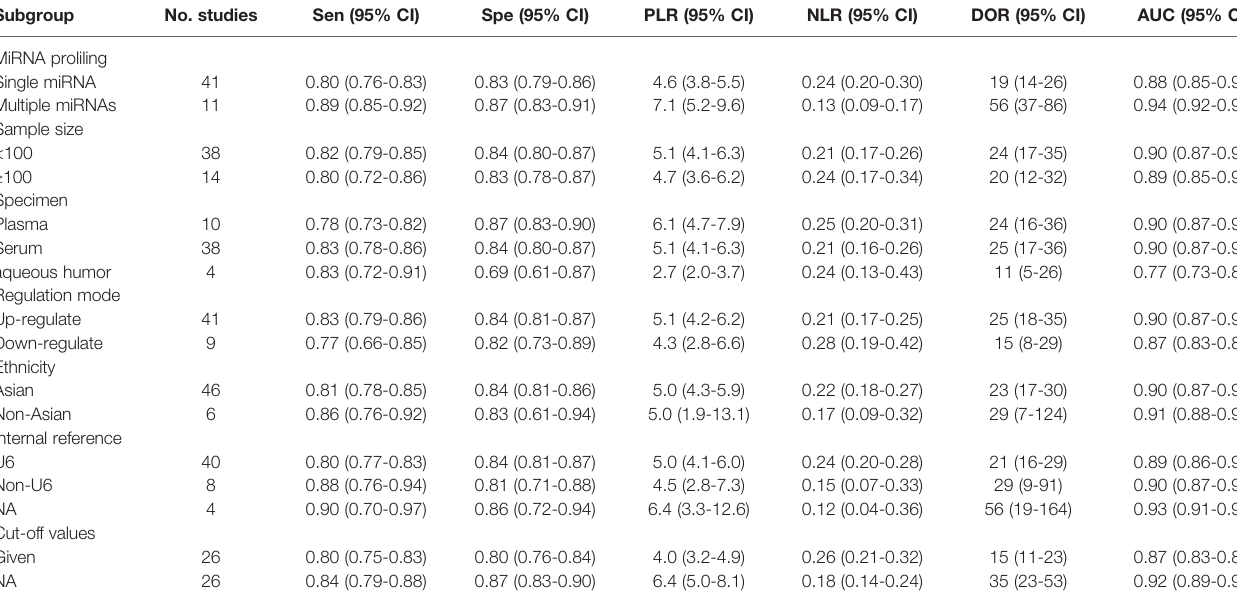
TABLE 2 | Summary estimates of diagnostic power and their 95% con fi dence intervals. Subgroup